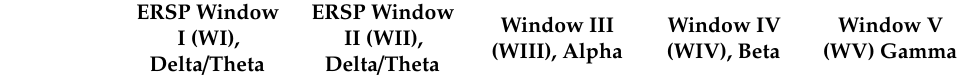
Table 1. Latency and dimensions of the frequency band for Windows of ERSP components, either ERS or ERD, following the laser in the Attend Laser Task and the conditioning stimuli in the fear conditioning protocol.